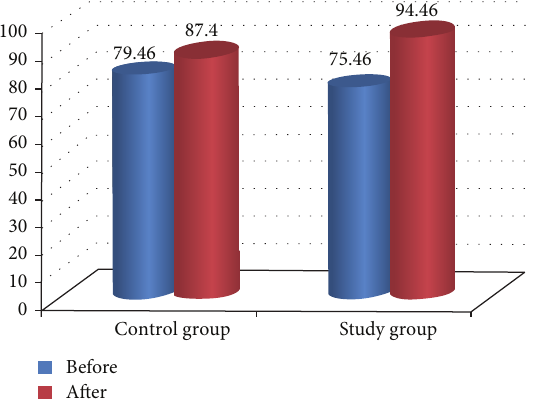
Figure 4: Comparison between pre- and posttreatment in stride length for both groups.